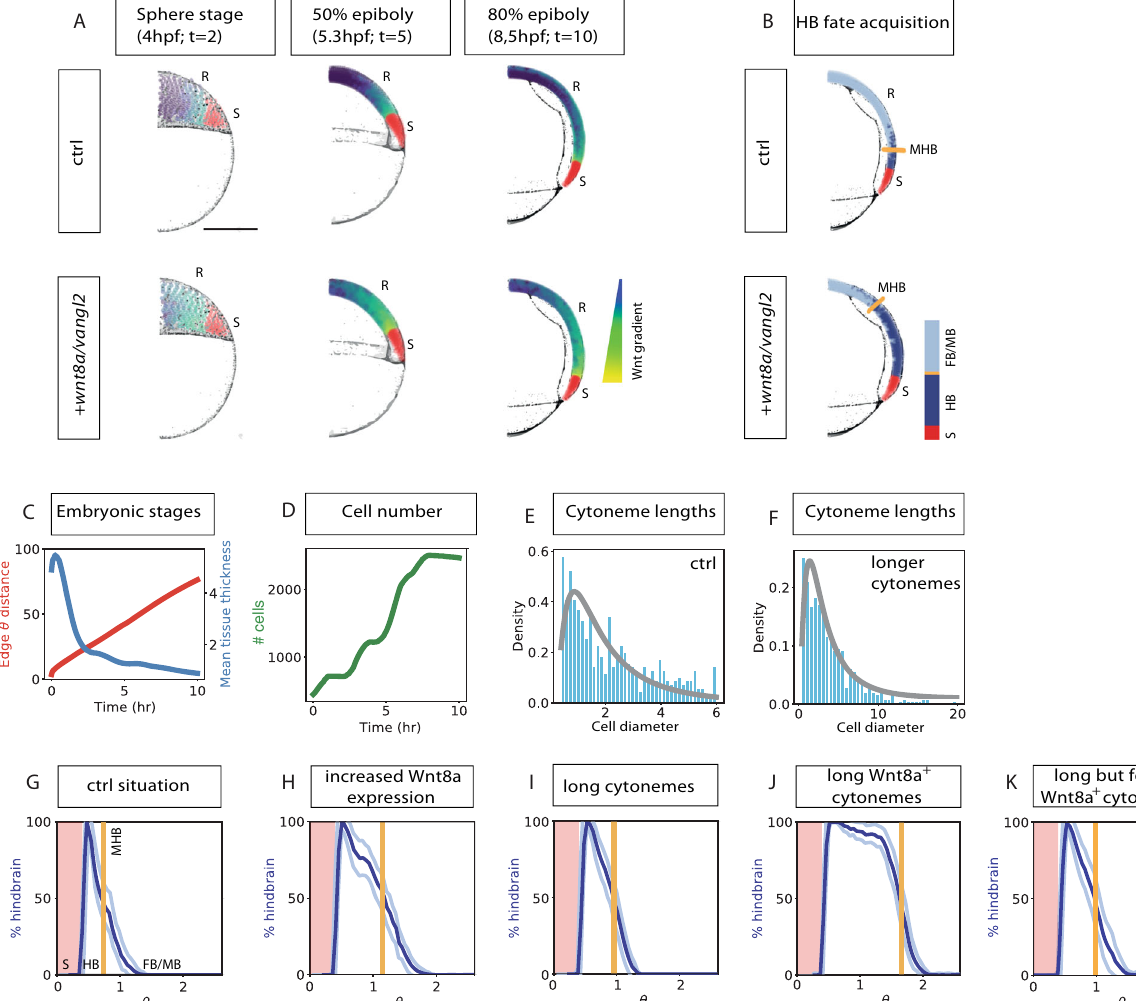
Fig. 7 Agent-based modeling predicts an essential role for Vangl2 in Wnt-mediated tissue patterning during zebra fi sh gastrulation. A , B Comparison of Wnt protein distribution in control zebra fi sh embryos with zebra fi sh embryos with Vangl2/Wnt8a overexpression. State of one realization of the model at the indicated time point ( t ): (Sphere stage = 4 hpf (hours post fertilization); 50% epiboly = 5.3 hpf; 80% epiboly = 8.5 hpf) for base parameter values and Wnt8a and Vangl2 over-expression parameters. Scale bar = 250 µ m. For the 80% epiboly panel, the fate of the cells is also plotted in B . Source cells (S), are indicated in red. R = Receiving cells. The colors of the cells in anterior tissue correspond to the relative level of Wnt8 protein received ( A ). For ease of viewing, Wnt8a protein values have been normalized by the maximum value attained by any cell across the simulation and log transformed. In the cell fate diagram ( B ), cells acquiring a hindbrain (HB) fate are marked in dark blue, whilst those not acquiring a hindbrain fate are marked in gray. The orange line marks the estimated midbrain-hindbrain boundary (MHB). C Tissue growth properties — a single simulation. Note that the mechanics of the tissue growth are preserved across all conditions and so this graph is representative of all simulations. The red curve shows the proportion of the yolk that is covered by the tissue at the indicated times. The blue curve shows the mean tissue thickness (in terms of the number of cells). D Evolution of the cell number. E, F Histograms of cytoneme lengths at the fi nal state of the simulation (normalized by cell diameter) for the control parameters ( E ) and with longer cytonemes ( F ). The gray curve shows a fi t of the data to a log-normal distribution with means 2.0 ( E ) and 3.8 ( F ). G – K Distributions of cell fates over the angular polar coordinate at the end state of the simulation according to a hindbrain Wnt8a threshold of 100 (AU) for control parameters. The length of an arc of a circle is equal to ∅ is equal to 250 µ m ( G ), Wnt8a overexpression parameters ( H ), longer cytonemes ( I ), longer Wnt8a positive cytonemes ( J ), long but fewer Wnt8a positive cytonemes ( K ). The dark and light blue curves respectively show the mean and standard deviations of the proportion of cell fates acquiring a hindbrain fate in 100 equi-spaced bins around the yolk over 100 model simulations for each condition. The orange line shows the estimated position of the MHB. FB/MB forebrain/midbrain. The red shaded area marks the position of the margin of wnt8a producing cells. Source data are provided as a Source Data fi